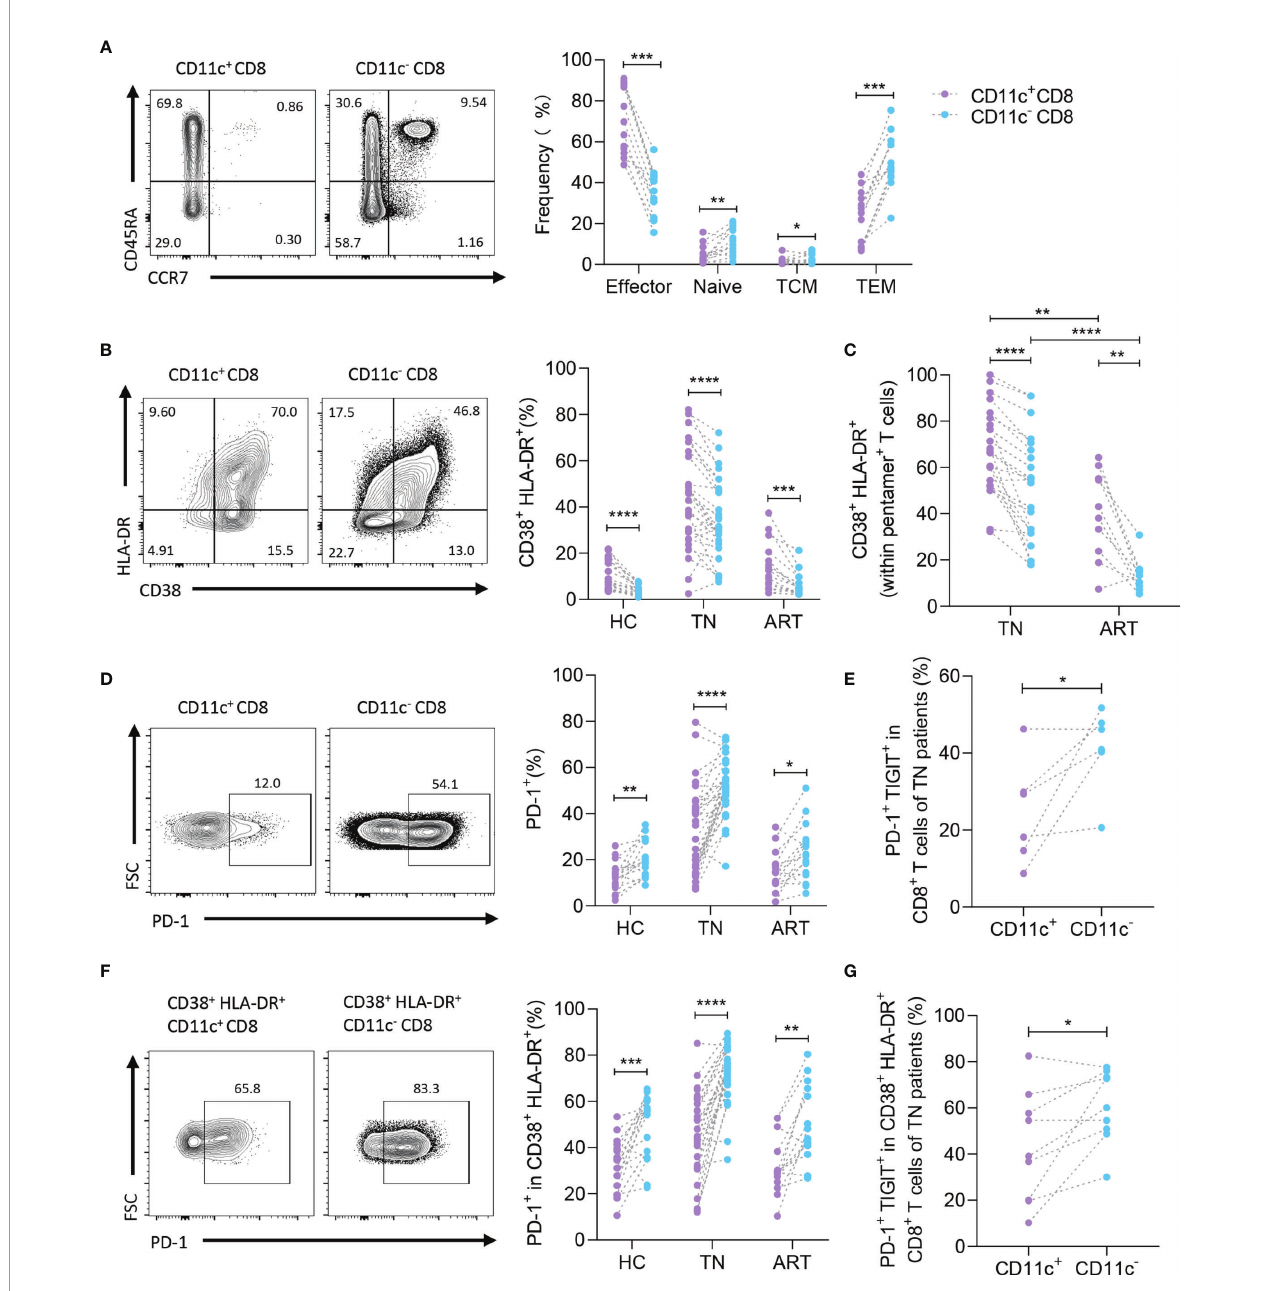
FIGURE 3 | CD11c + CD8 + T cells show higher activated and lower exhausted phenotypes. (A) Representative fl ow cytometry plots and the frequencies of effector (CCR7 - CD45RA + ), naïve (CCR7 + CD45RA + ), central memory (CCR7 + CD45RA - ) (T CM ), and effective memory (CCR7 - CD45RA - ) (T EM ) CD8 + T cell subsets. (B) Representative fl ow cytometry plots and the frequencies of activated (CD38 + HLA-DR + ) CD8 + T cells in CD11c + and CD11c - CD8 + T cells. (C) Frequencies of activated HIV-1-speci fi c CD8 + T cells in CD11c + and CD11c - CD8 + T cells. (D) Representative fl ow cytometry plots of PD-1 expression (left panel), and frequency of PD-1 + T cells among the CD11c + and CD11c - CD8 + T cells (right panel). (E) PD-1 + TIGIT + T cells in CD11c + and CD11c - CD8 + T cells. (F) Frequency of PD-1 and (G) PD-1 + TIGIT + in CD38 + HLA-DR + CD11c + and CD11c - CD8 + T cells. The numbers indicate the percentage of gated cells in representative fl ow cytometry plots. * P < 0.05; ** P < 0.01; *** P < 0.001; **** P <